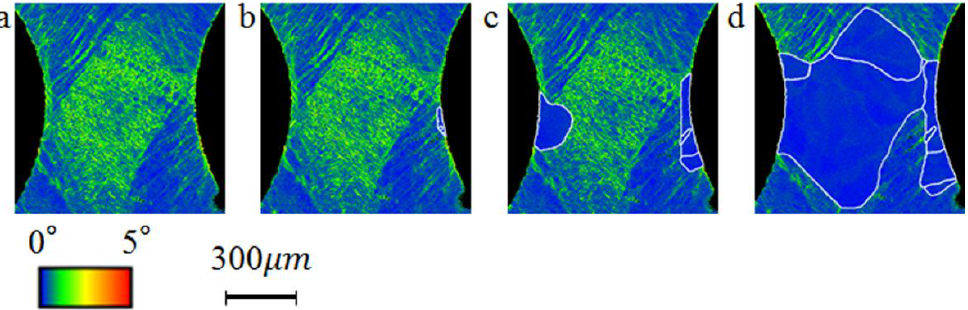
Figure 11. Microstructure evolution of specimen 2-2 at annealing time ( a ) 0 min; ( b ) 5 min; ( c ) 30 min; and ( d ) 60 min. Grain boundaries were highlighted with white lines.